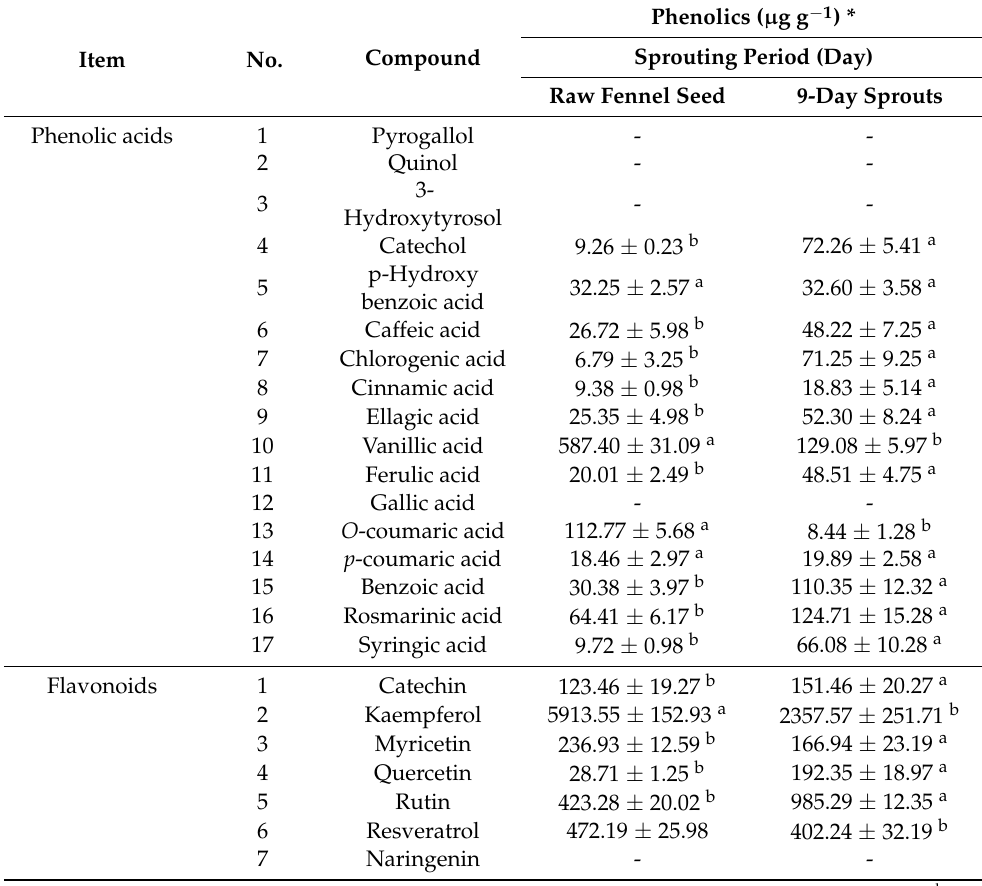
Table 2. Quantitative analysis of phenolic compounds in F. vulgare during sprouting at 17 ± 1 ◦ C and 90–93% RH (mean ± SE), n = 3. Phenolics ( µ g g − 1 ) * Sprouting Period (Day) Item No. Compound Raw Fennel Seed 9-Day Sprouts Phenolic acids 1 Pyrogallol - - 2 Quinol